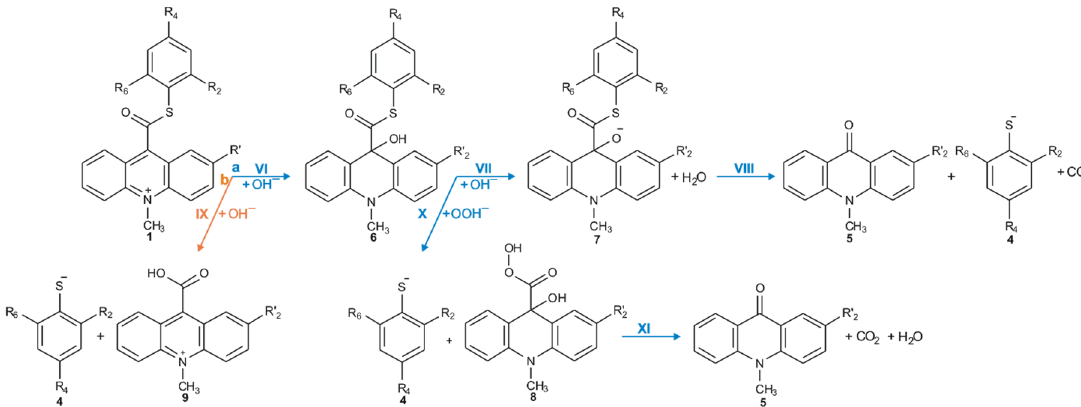
Scheme 5. Non-CL pathways of ATEs: ( a , blue) the transformation of the acridinium cation to the non-emitting product, and ( b , orange) the hydrolysis of the acridinium